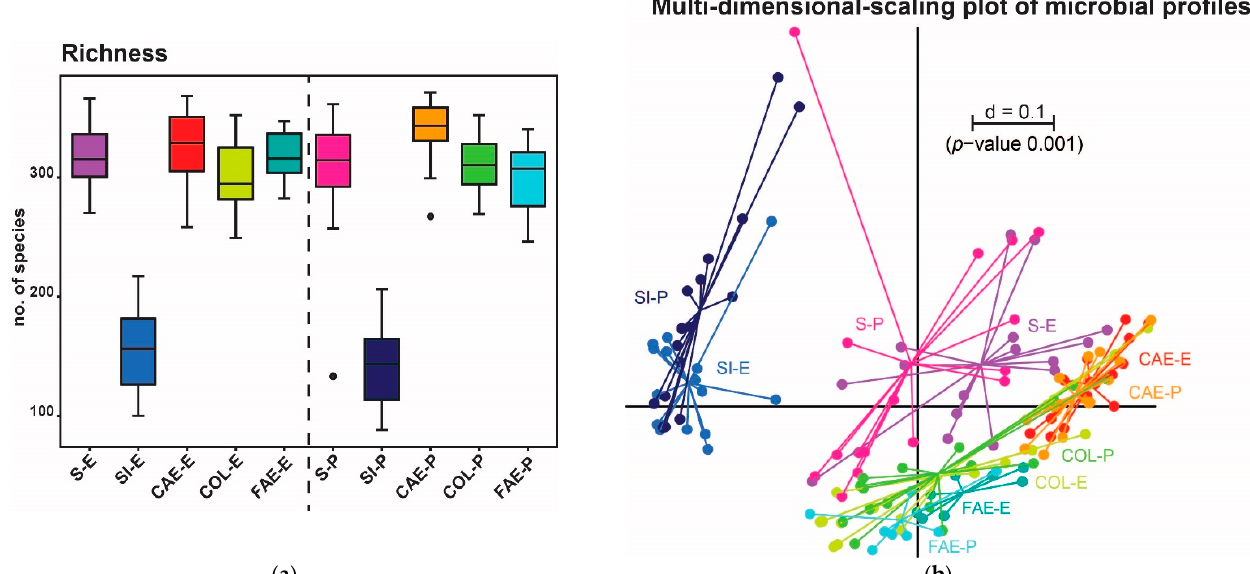
Figure 2. ( a ) α -diversity shown as richness in different intestinal regions of trial 2. The group fed with extruded feed is plotted on the left, the pelleted fed group on the right. ( b ) β -diversity in trial 2 is shown as an MDS plot. The scale indicates the distance between samples (d = 0.1 marks 10% difference). E = extruded diet, P = pelleted diet, S = stomach, SI = small intestine, CAE = cecum, COL = colon, FAE = feces.